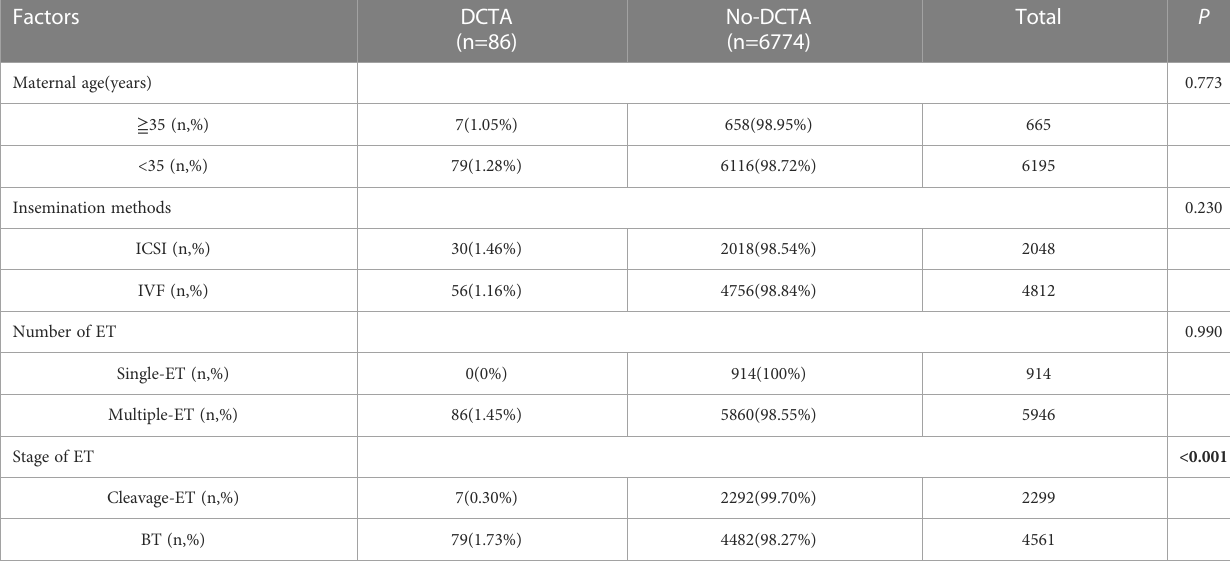
TABLE 3 Risk factors of DCTA in the frozen ET cycle by multivariate logistic regression analyses.